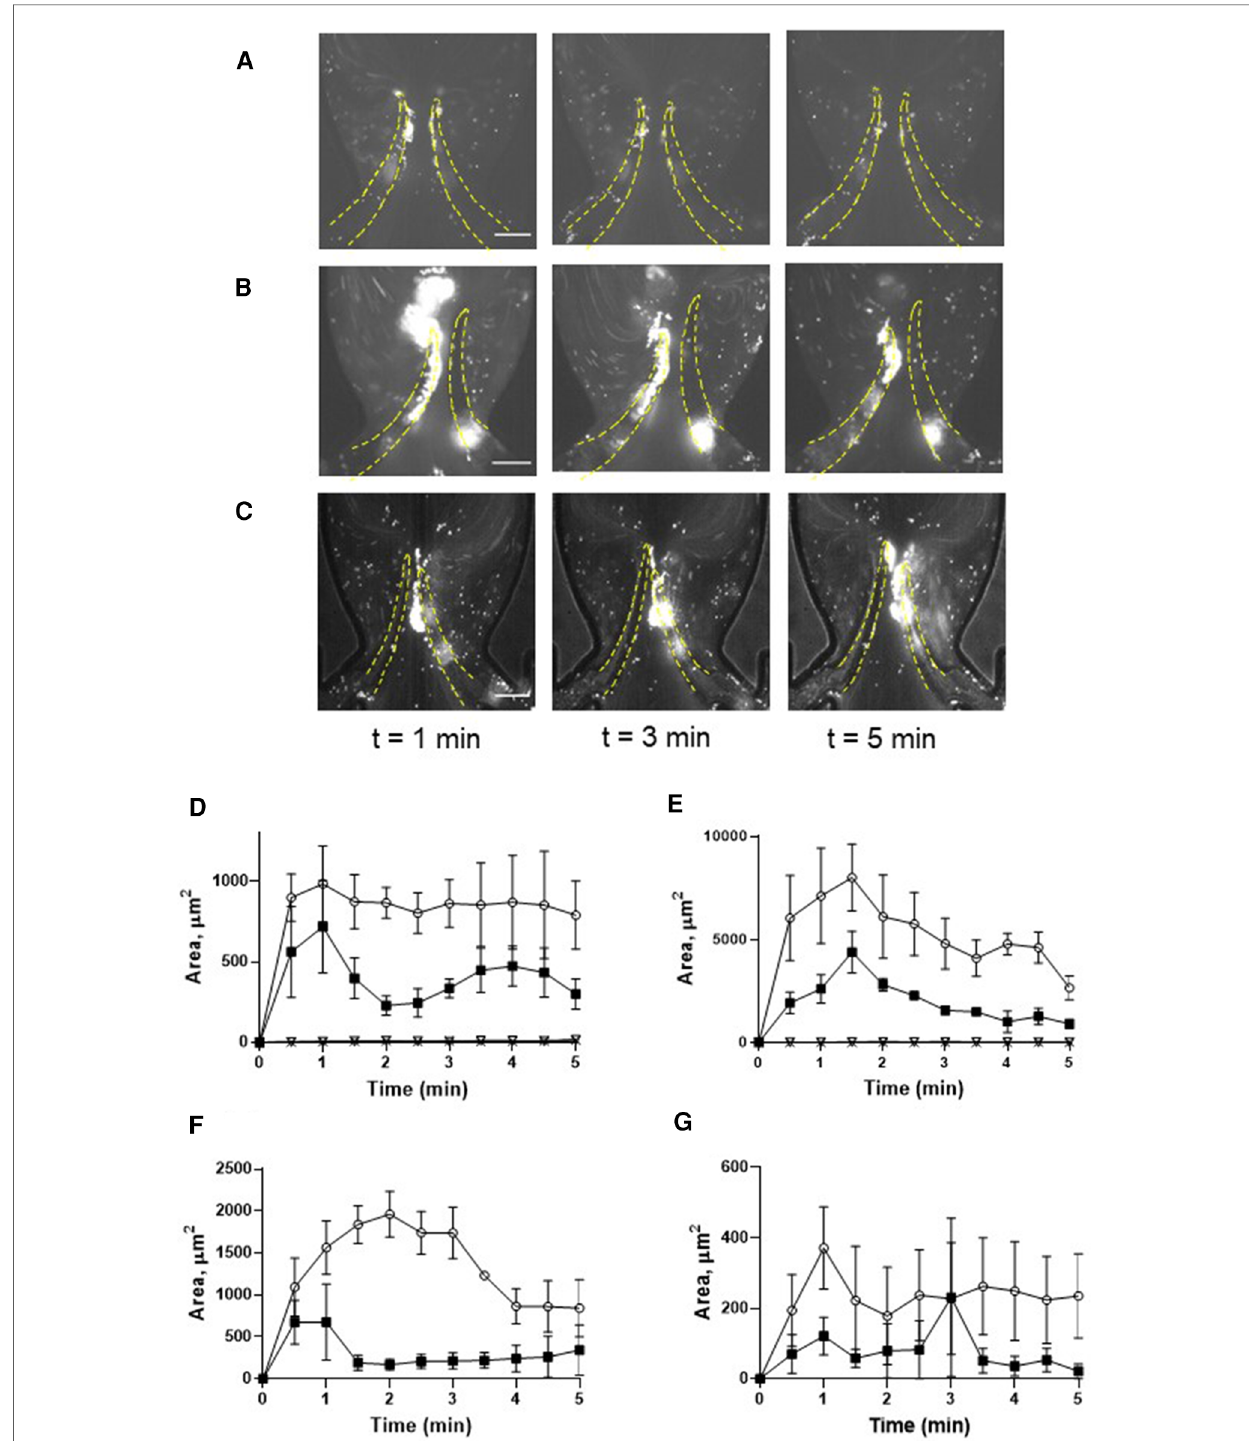
FIGURE 2 Deposition of unchallenged platelets on symmetrical and non-symmetrical valves. Blood reconstituted with fl uorescently labelled platelets was perfused through either symmetrical ( A ) or non-symmetrical ( B ) valves, and resting platelets were preincubated with 9 mM epti fi batide ( C ) through a symmetrical valve for 5 min. Quantitation of resting platelet accumulation on more fl exible (TL area, circles; TS area, open triangles) and less fl exible/immobile (TL area, squares; TS area, Xs) lea fl ets of the symmetrical ( D ) or non-symmetrical ( E ) valve. ( F,G ) Quantitation of epti fi batide-treated platelet accumulation at the TL ( F ) and TS ( G ) regions. Scale bar 100 µm. Error bars represent SEM, n